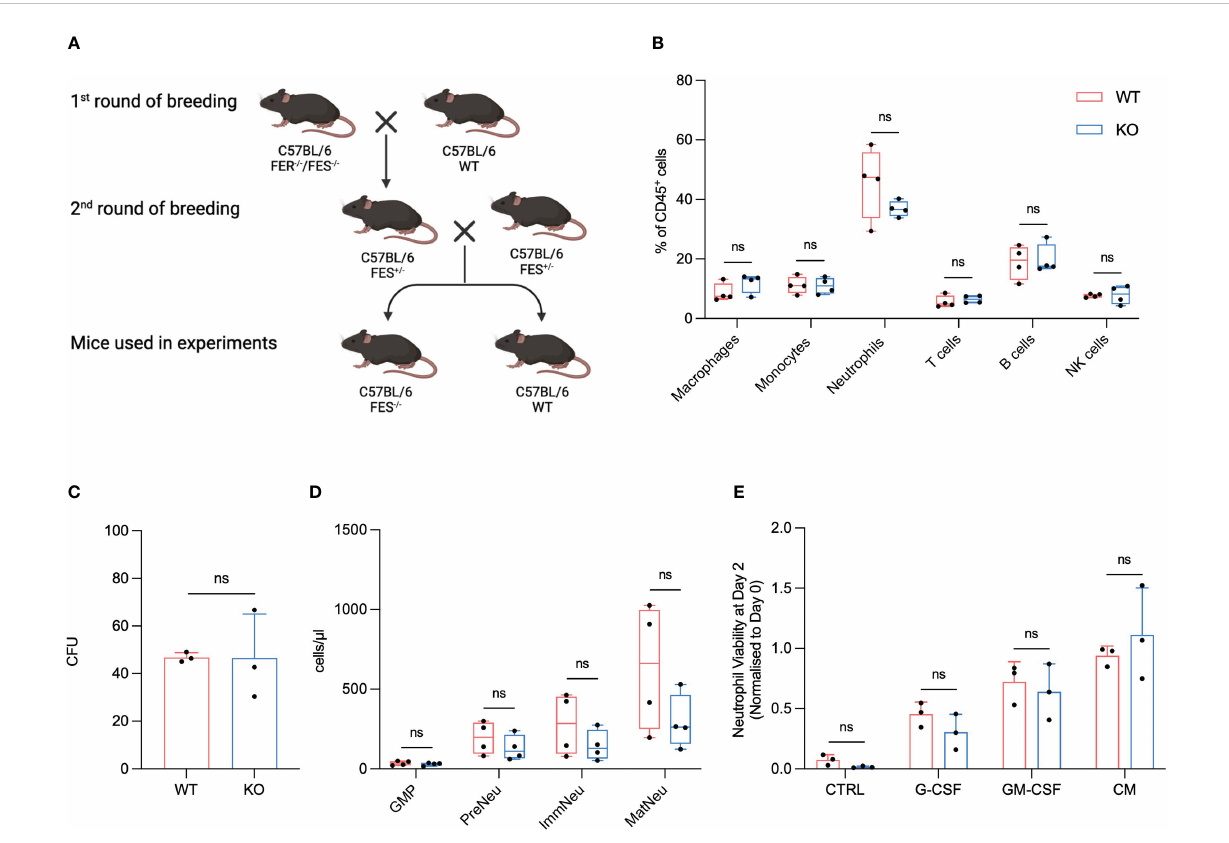
FIGURE 1 FES null mice show no alterations in immune cell composition, granulopoiesis and neutrophil viability compared to wildtype mice. (A) , FES/FER null mice (C57BL/6) was bred with WT C57BL/6, and the offspring subsequently backcrossed until FES +/- mice were obtained. The FES +/- offspring was then used for the 2 nd round of breeding. Only WT and FES -/- offspring from 2 nd round of breeding was use for experiments. (B) , Flow cytometry analysis of immune cells from BM from healthy WT and FES -/- mice (WT mice n=4, FES -/- mice n=4). (C) , Colony-forming unit (CFU) assay of BM cells from healthy WT and FES -/- mice. Colonies with >20 cells were quanti fi ed after 3 days (n=3 independent experiments). (D) , Flow cytometry analysis of GMPs, pre-neutrophils (PreNeu), immature (ImmNeu) and mature (MatNeu) neutrophils from BM from healthy WT and FES -/- mice (WT mice n=4, FES -/- mice n=4). (E) , quanti fi cation of neutrophil viability assay. Neutrophils were isolated from BM from either WT or FES -/- mice and stimulated over two days with KPC-CM, 20 ng/mL GM-CSF or 20 ng/mL G-CSF (n = 3 independent experiments). Bar graphs represent mean and standard deviation; hypothesis testing was performed using unpaired two-sided Student ’ s t test. ns, Non signi fi